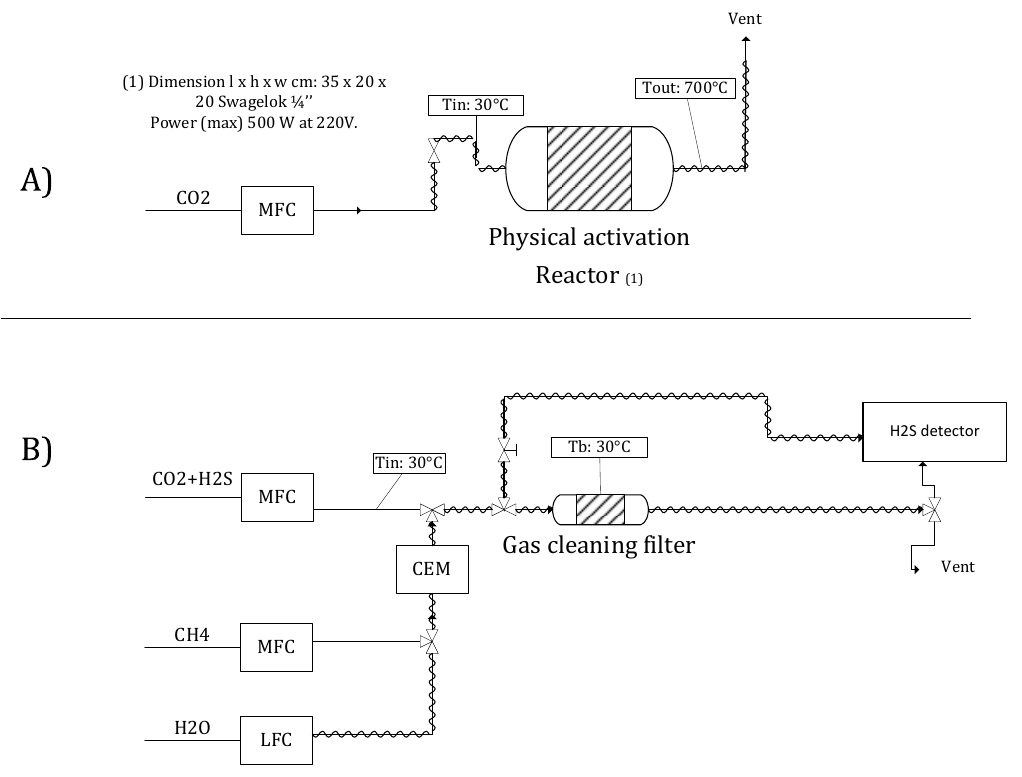
Figure 1. Experimental set-up: ( a ) activation test rig, ( b ) sorbent material testing for VOCs removal.